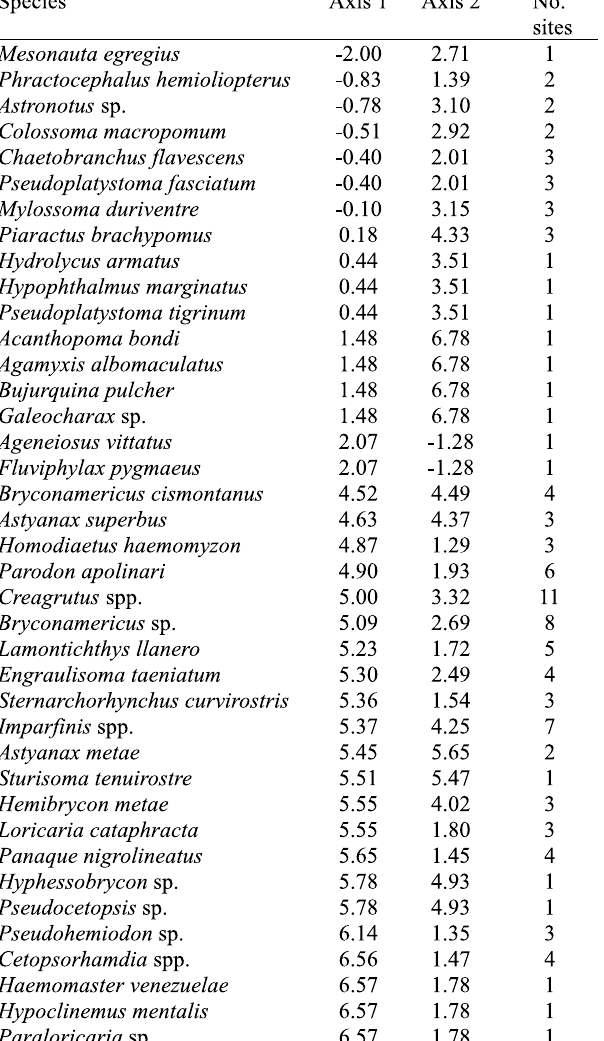
Table 1. Scores and frequencies of occurrence for species scoring highest and lowest values on the first two DCA ordination axes (see also Appendix